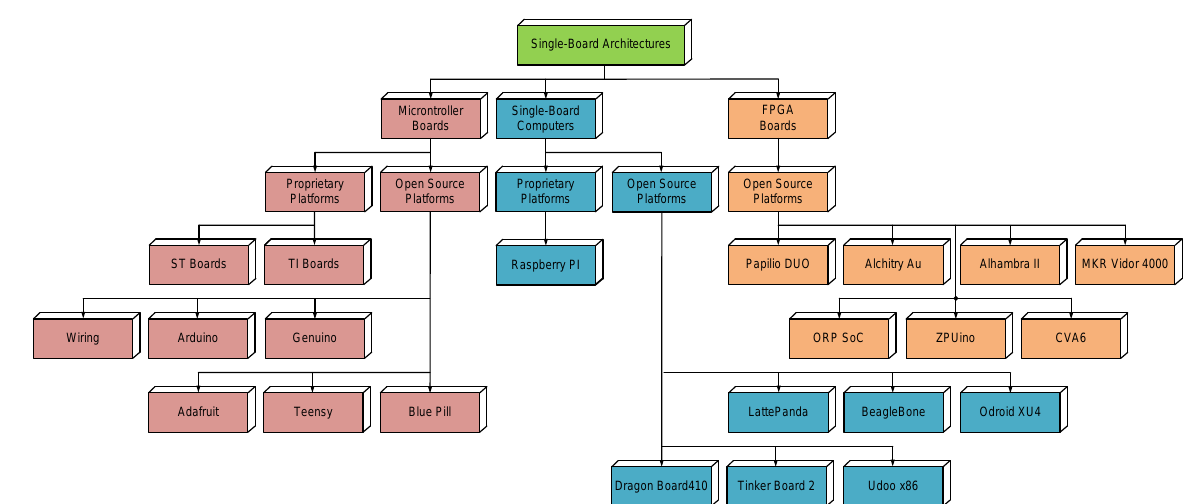
Figure 2. Single Board Architectures classification and main platforms.